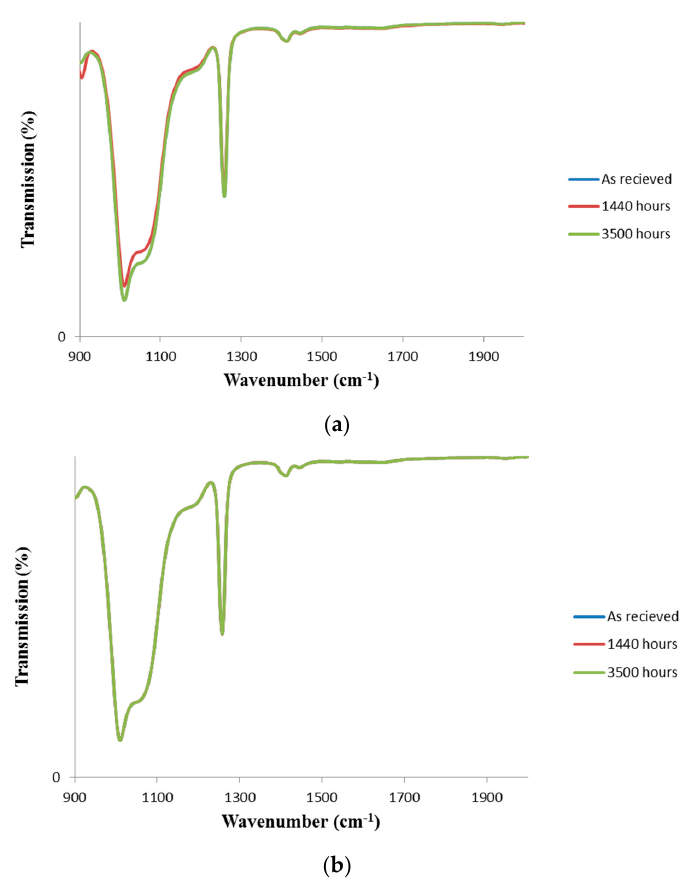
Figure 3. FTIR-ATR spectra of samples exposed to ( a ) swimming pool environment at 100 °C; and ( b ) 100% RH environment at 100 °C.